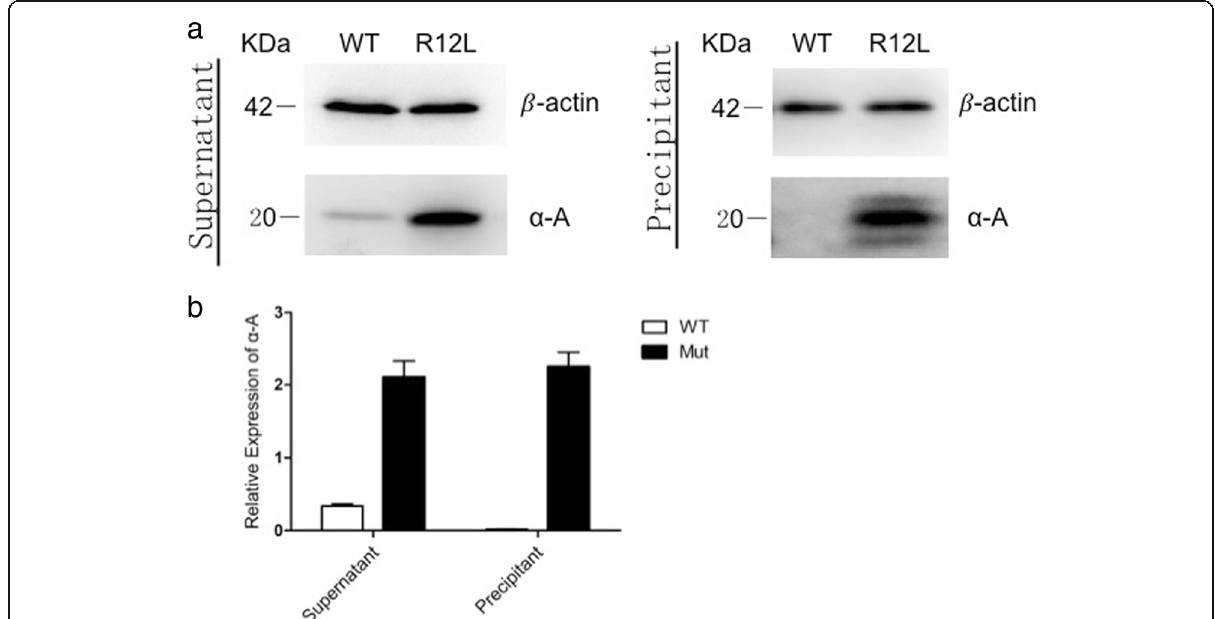
Fig. 5 Protein expression levels of WT-CRYAA and R12L-CRYAA transfected into HEK293T cells. Western blots were performed with the anti- α A crystallin antibody. β -actin was used as the loading control. ( a ) The mutant R12L-CRYAA in HEK293T cells had a greatly increased level of protein expression when compared with the wild-type allele. Moreover, a large amount of the mutant protein aggregated in the precipitate where the wild-type protein was not detected. Expression levels of the β -actin loading control in both wild-type and the mutant proteins were comparable. ( b ) Each bar represents the mean ± standard deviation of three individual experiments. The difference was significance ( p < 0.01) transfected with wild-type CRYAA showed a homogenous with an anti-alpha A crystallin antibody. Photomicrographs show the distribution of immunoreactive α A-crystallin distribution of its expression in the cytoplasm and there (green) and DAPI-stained nuclei (blue) in the HeLa cells was a little or no aggregation in the cells. In contrast, sig- nificant intracellular aggregation was seen in a number of (Fig. 6). Both wild-type CRYAA and mutated R12L-CRYAA were predominantly localized in the cytoplasm. Cells the cells transfected with the mutant R12L-CRYAA.